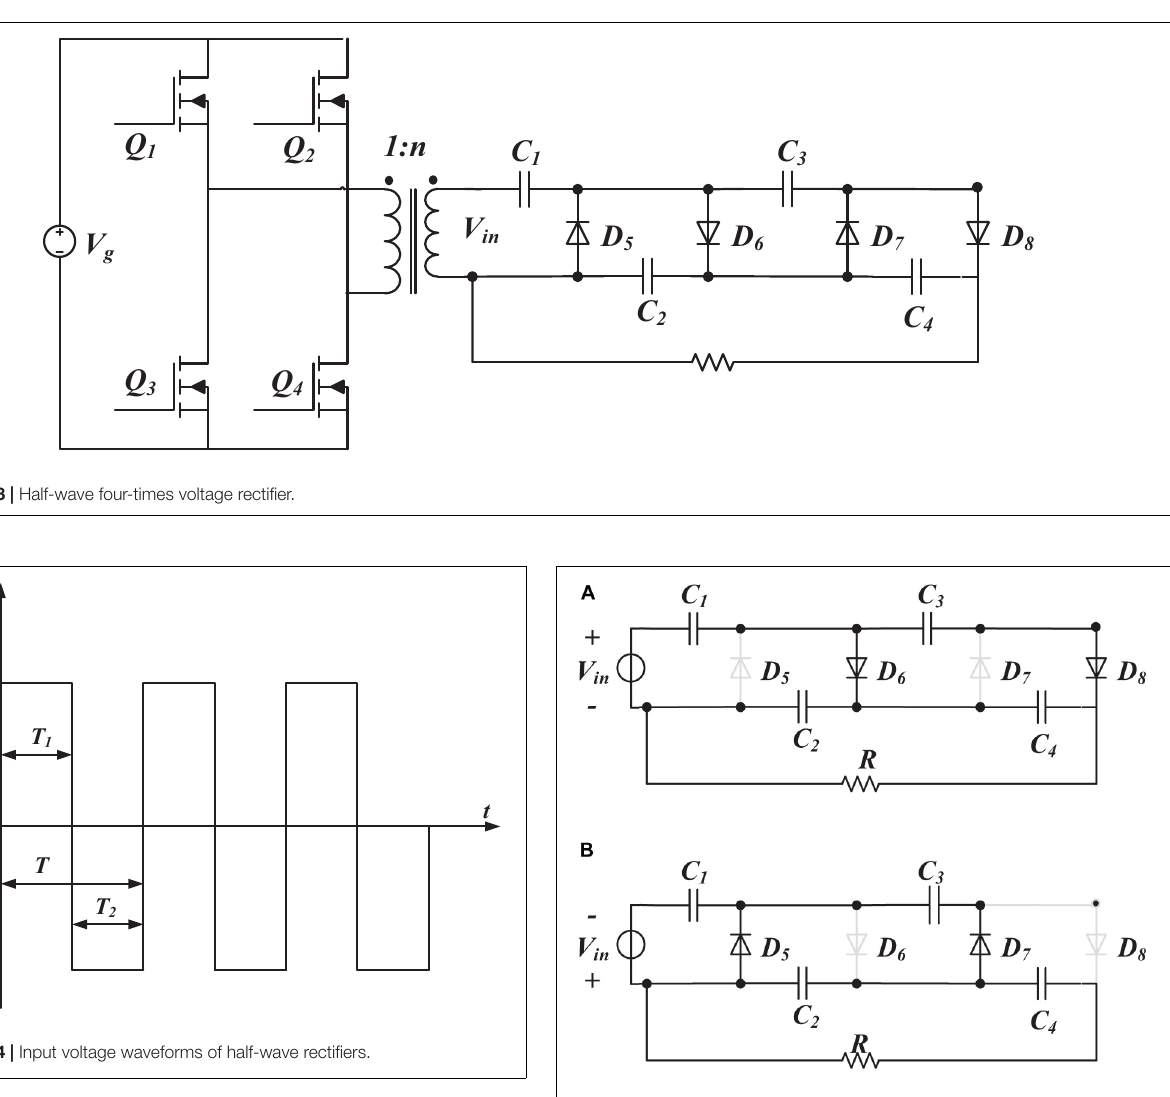
FIGURE 6 | Equivalent circuit for (k+1) cycle circuit operation. (A) ( kT ) ∼ ( kT + T 1 ) . (B) ( kT + T 1 ) ∼ [ ( k + 1 ) T ] .